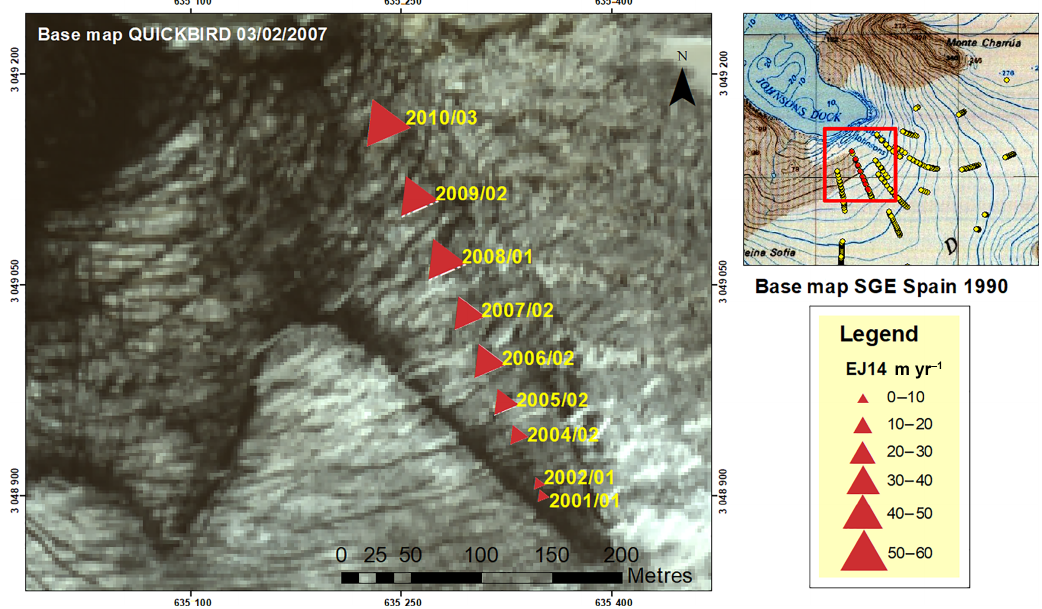
Figure 3. Map showing the time evolution of stake EJ14. Horizontal velocities and times for various positions are shown. The stake fell into a crevasse during 2010–2011, so it does not appear in Fig. 2. The inset shows the location of the main image (in the inset, EJ14 positions are shown in green). In this, and the following figures, UTM coordinates (sheet 20S) are indicated. The background satellite image is a photo from the QUICKBIRD system program (2007).